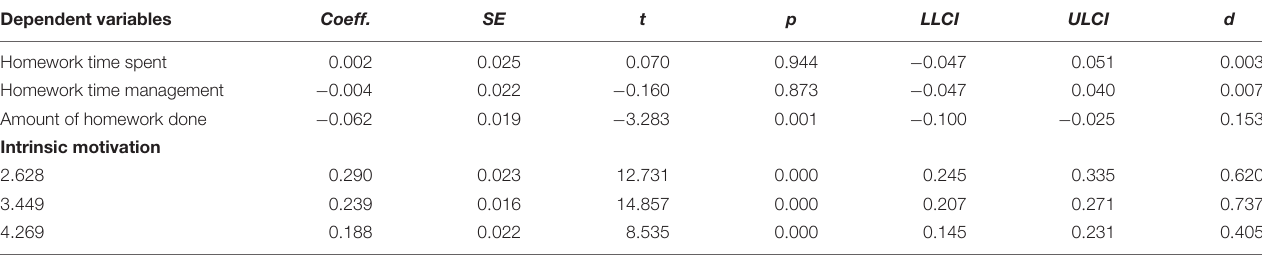
TABLE 3 | Summary of the moderation of intrinsic motivation of the effect of prior achievement on student homework behavioral engagement (interaction effects). Dependent variables Coeff. SE t p LLCI ULCI d Homework time spent 0 . 002 0 . 025 0 .